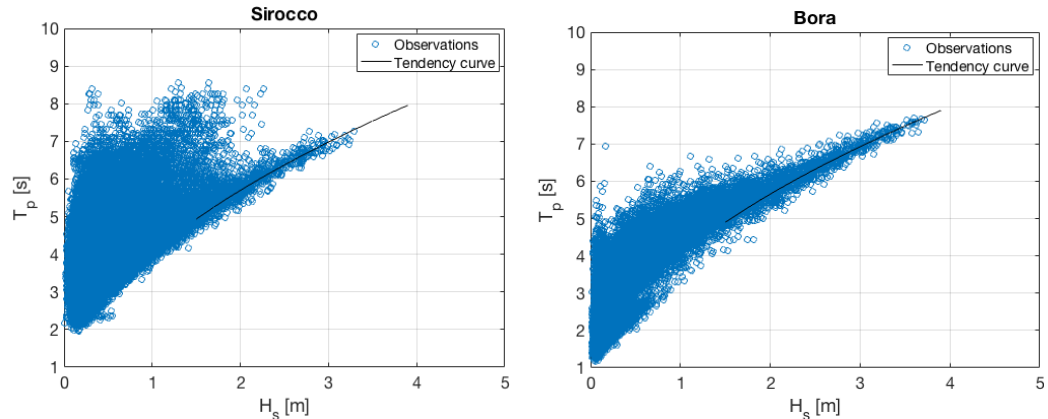
Figure 5. Relation between H s and T p for Sirocco ( left panel ) and Bora ( right panel ) events for the NAUSICAA-transposed observations at the study site. Tendency curves for the extreme events are also plotted with solid black lines.